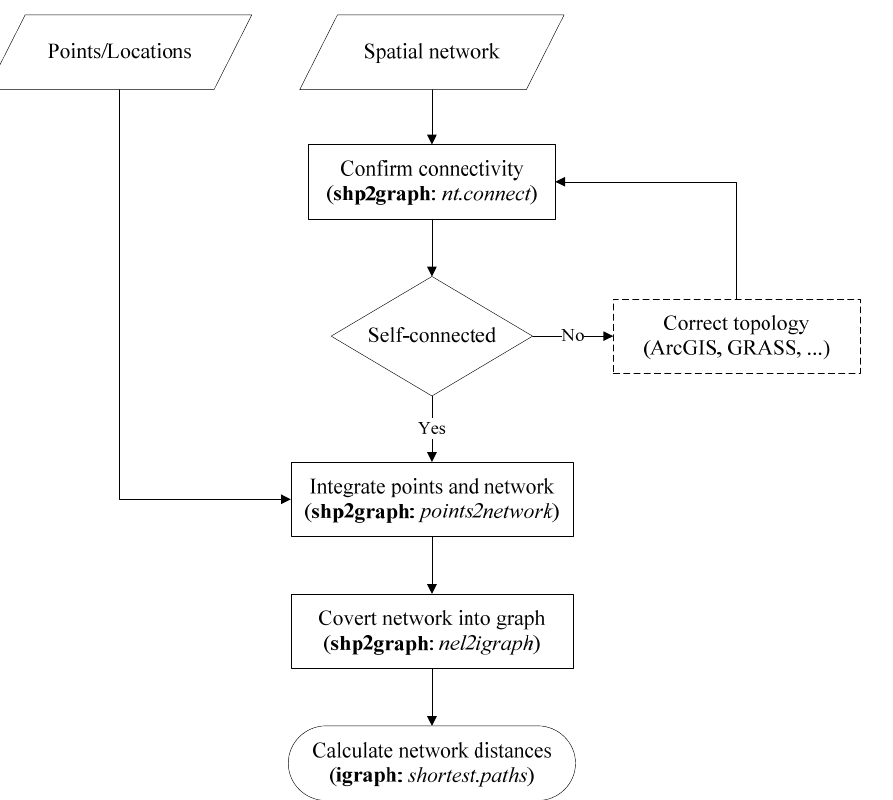
Figure 13. Flow chart of calculating network distances with shp2graph and igraph.